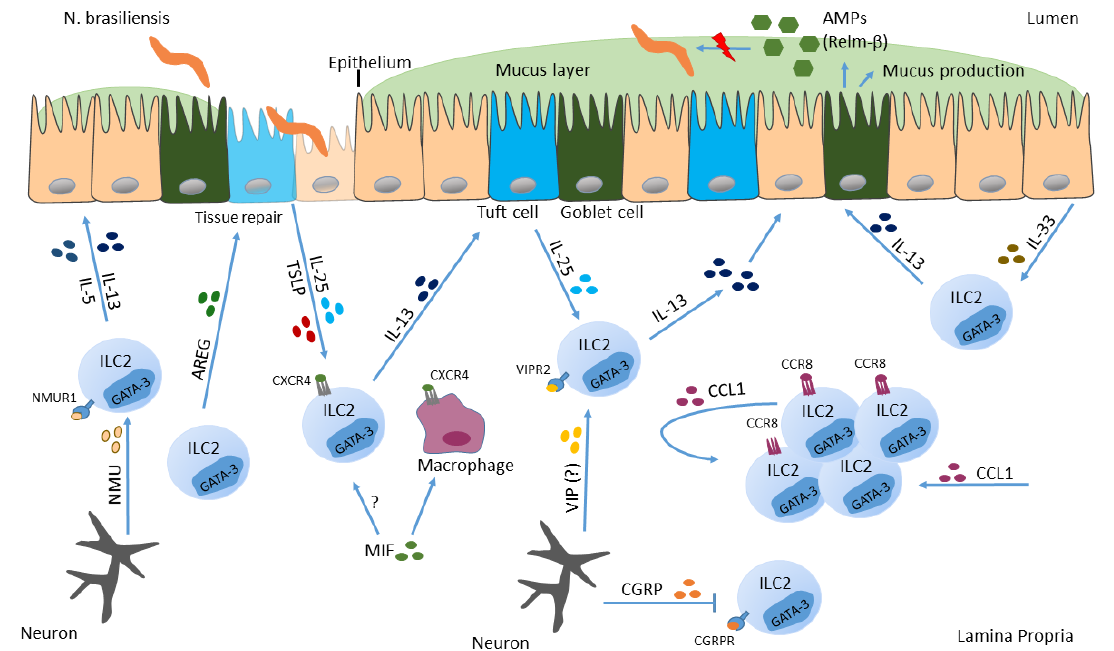
Figure 1. Action of ILC2s in Nippostrongylus brasiliensis infection. Helminths can infect barrier surfaces such as the small intestine. There, intestinal epithelial cells secrete IL-33, IL-25 and TSLP in response to pathogen invasion and cell destruction, which in turn activates ILC2s to secrete IL-13. In addition to epithelial cells, also neurons respond to NB and promote type 2 immune response. Furthermore, IL-13 induces goblet cells to secrete mucus, and induces tuft cell hyperplasia, resulting in expulsion of the parasite.